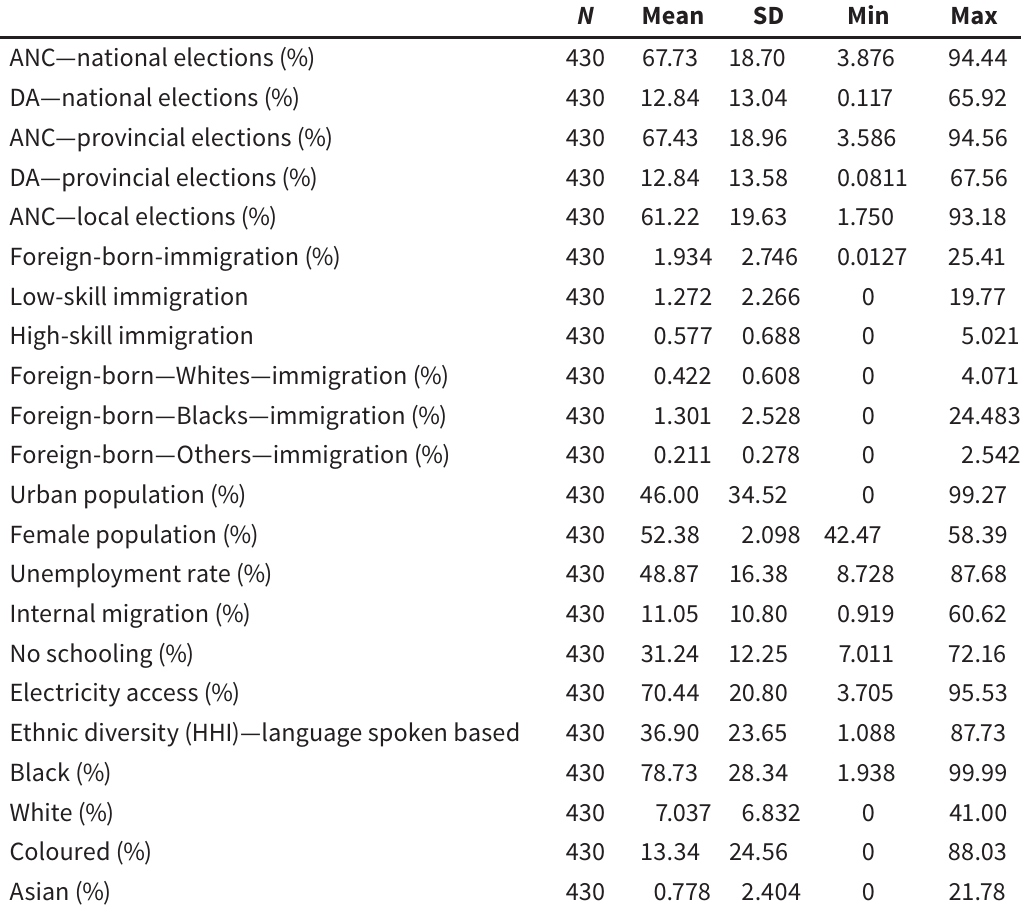
Data sources : IPUMS International, South Africa Electoral Commission.